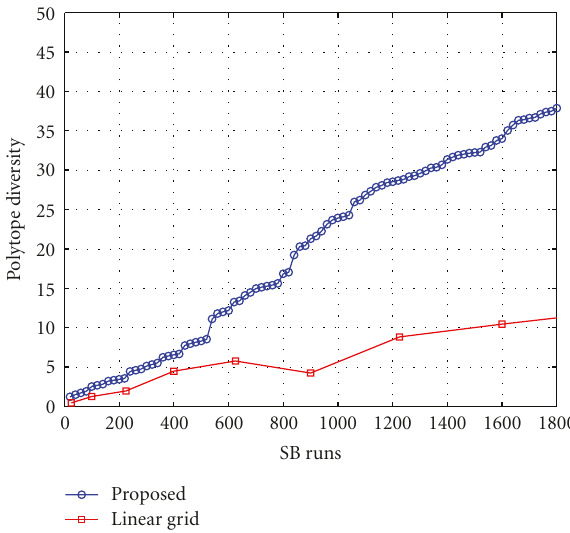
Figure 6: Diversity for di ff erent SB runs for the 2-user scenario.